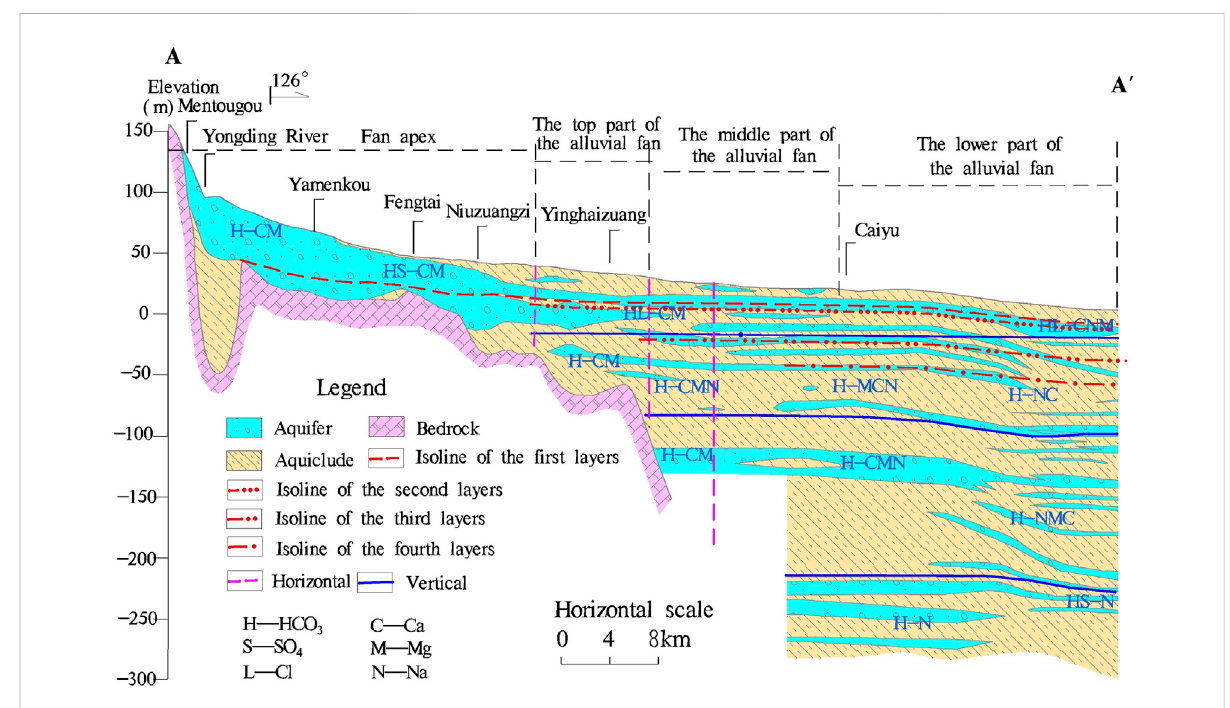
FIGURE 11 Hydrogeological pro fi le of the Yongding River alluvial